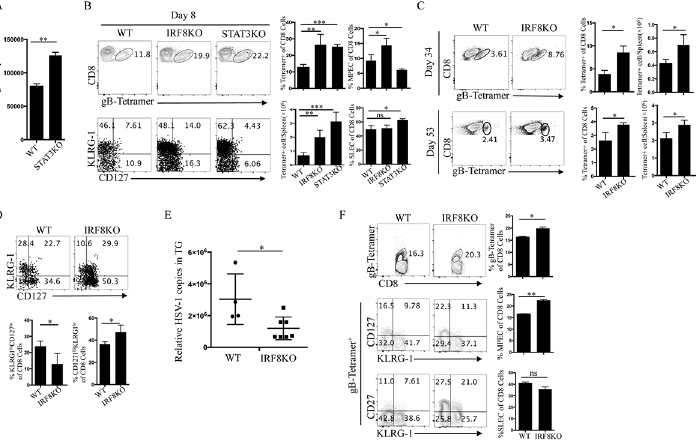
Fig 5. IRF8 regulates the expansion of memory precursor effector cells (MPECs). (A) WT or STAT3KO mice were infected with HSV-1 and RNA from sorted CD8 + T cells on day 8 p.i were analyzed by qPCR for IRF8 expression. (B-D) WT or CD4-IRF8KO mice were infected with HSV-1 and CD8 + T cells were isolated from the spleen on day (B) 8 p.i, day (C) 34 or day 53 p.i and analyzed by FACS. (B) CD8 + T cells were first gated on gB-Tetramer+ population and then the percentages of MPEC (KLRG-1 lo CD127 hi ) and SLEC (KLRG hi CD127 lo ) in gB-Tetramer + population were analyzed. (D) Flow plots represent the total gB-tetramer positive T cell population. The numbers in quadrants indicate percentages of CD8 + gB-tetramer-positive T cells expressing KLRG-1 and/or CD127. (E) Genomic DNA extracted from TG were analyzed by qPCR of the HSV-1 genes. (F) WT and CD4-IRF8KO mice were also infected with HSV-1 by the intraperitoneal route (i.p.) and CD8 + T cells were isolated from the spleens of infected mice on day 6 p.i, gated on CD8 +